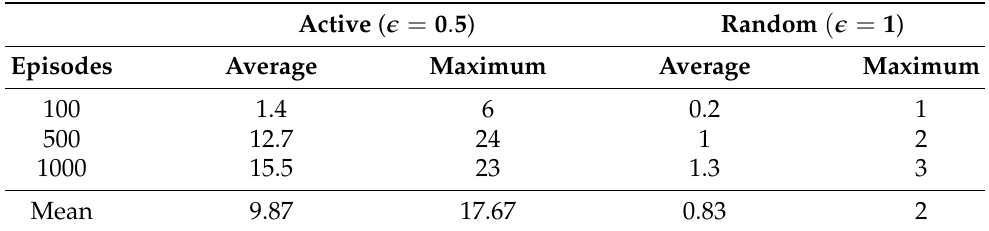
Table 4. Number of positively graded weight sets obtained by active and random exploration.